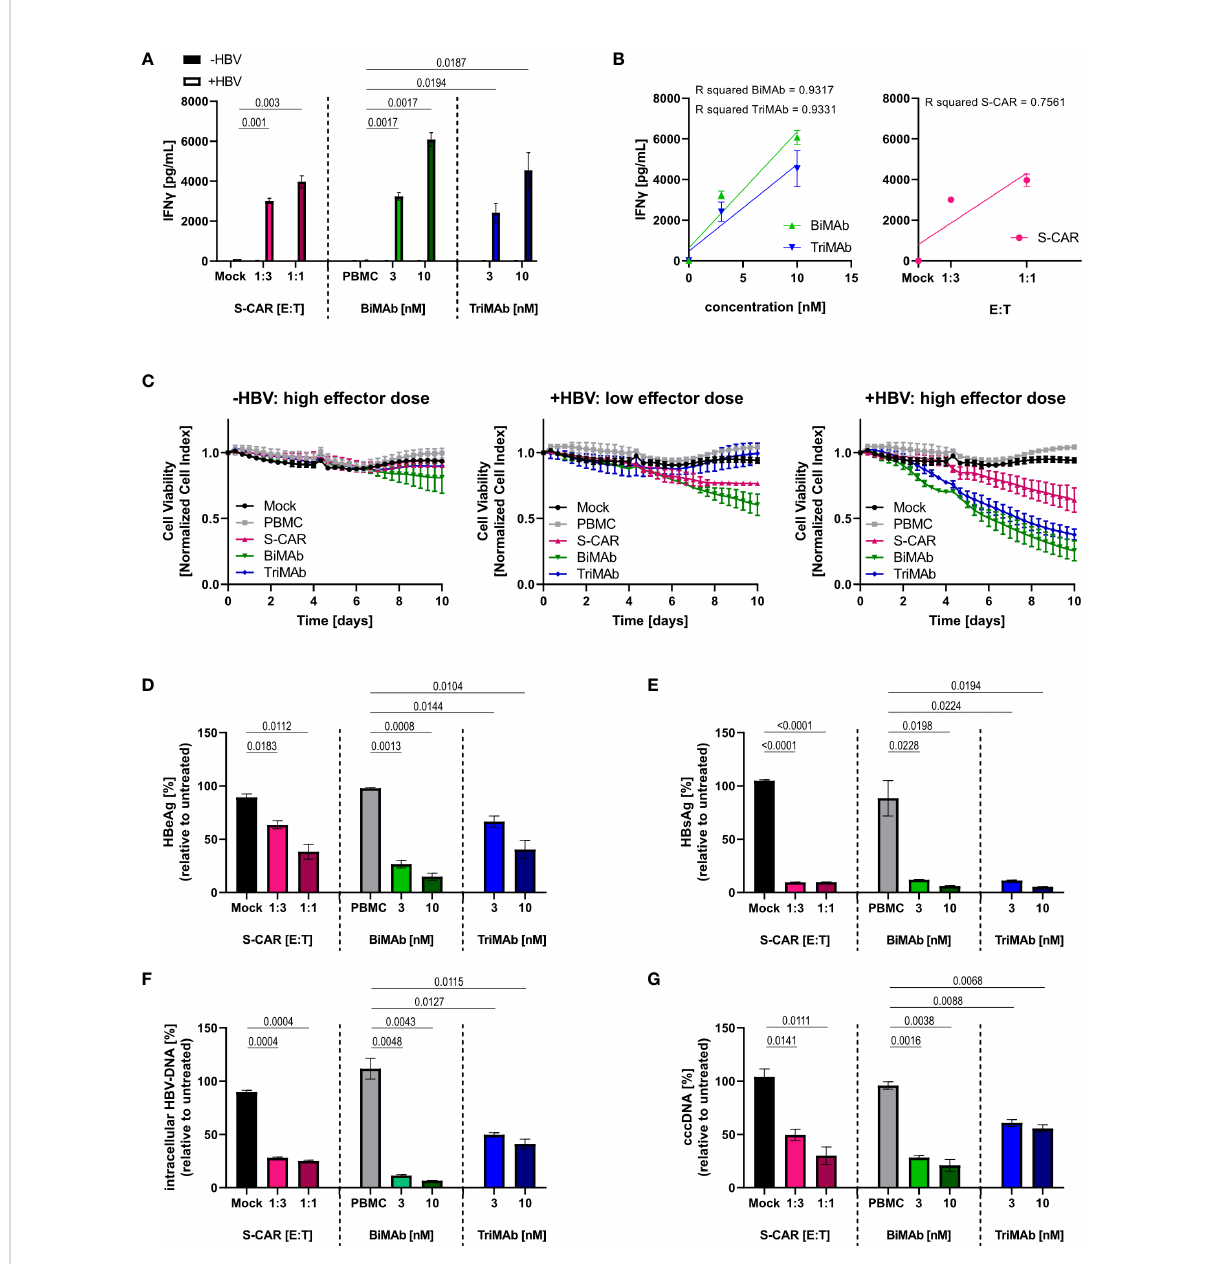
FIGURE 3 Dose dependency, speci fi city and antiviral effect of T cells activated via S-CAR, BiMAb and TriMAb. HepG2-NTCP-K7 cells were infected at an MOI of 500 virions/cell (+HBV) and co-cultured for 12 days with either S-CAR-grafted T cells at at E:T ratios of 1:3 (low effector dose) or 1:1 (high effector dose) or PBMC in combination with BiMAb a CD3 and BiMAb a CD28 in a 1:1 ratio or TriMAb at the indicated concentrations (3 nM = low dose, 10 nM = high dose). Uninfected HepG2 cells (-HBV) and treatment with mock-transduced T cells or with PBMC in the absence of engager antibodies served as controls. The number of PBMC was adjusted to an E:T ratio of 1:1, expecting PBMC to contain 60% T cells. (A) The IFN g concentration in the supernatant of co-cultures on day 3 was quanti fi ed by ELISA. (B) The coef fi cient of determination (R 2 ) between IFN g levels in the supernatant and antibody concentration (left) or E:T ratio (right) was calculated using the Pearson correlation. Trend lines were calculated by simple linear regression. (C) The viability of uninfected controls (left), infected HepG2 cells treated with low effector dose (middle), or high effector dose (right) was determined over 10 days employing an xCELLigence real-time cell analyzer and plotted over time. (A – C) Data are presented as mean values ± SD of triplicates (n = 3). Levels of (D) HBeAg and (E) HBsAg in the supernatant produced from day 9-12. (F) Intracellular HBV-DNA and (G) cccDNA in cell lysates were quanti fi ed by qPCR after 12 days of co-culture. (D – G) Results are presented as percentage relative to untreated controls. Data are presented as mean values ± SD of duplicates (n = 2). To calculate p values, we employed 2- tailed unpaired